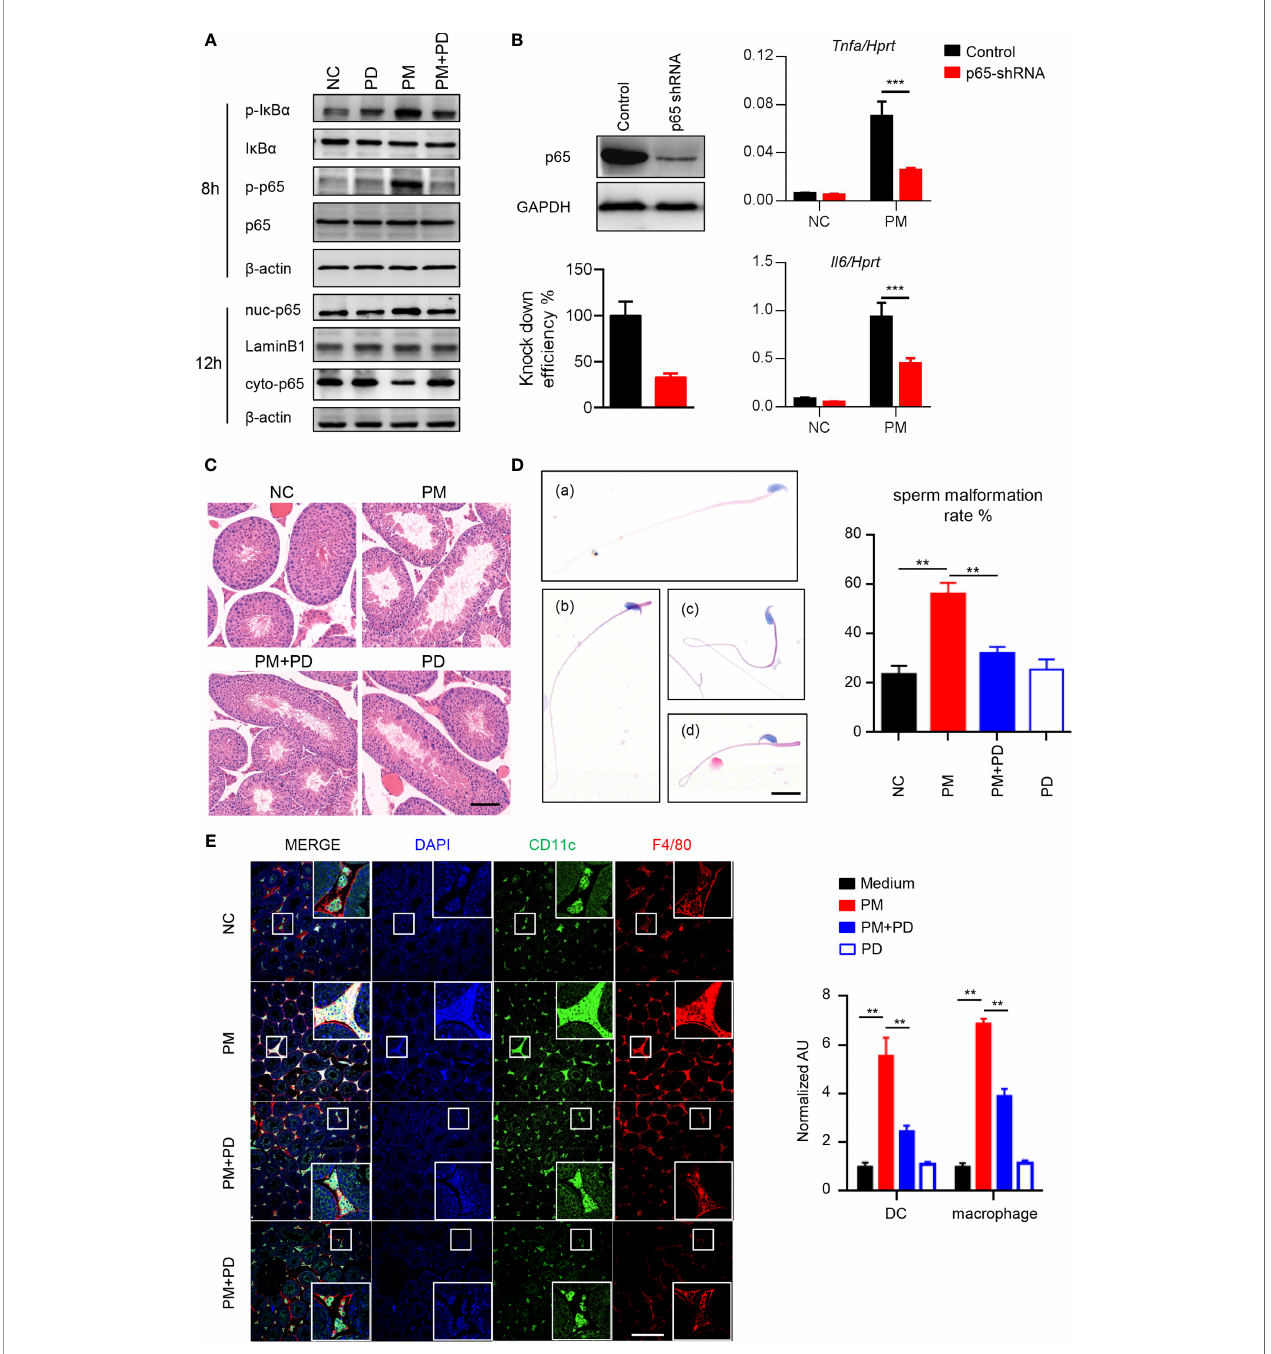
FIGURE 2 | PM exposure induced orchitis in mice is NF- k B signaling dependent. (A) Immunoblot analysis of phosphorylation of I k B a and p65 and protein level of I k B a and p65 in TM3 cells after 200 m g/ml PM administration for 8 hours. b -actin was used as the loading control. (B) Expression analysis of Il6 and Tnfa in the p65 knockdown TM3 cells after 200 m g/ml PM administration for 12 hours. The knockdown ef fi ciency was analyzed by western blot 48 h post transfection (left panel). The intensity of signaling was quanti fi ed. (C) H&E staining evaluation of empty areas of seminiferous tubules in testes of mice after 7 days of PM exposure with or without PDTC administration. In (C – E) , NC, PBS; PM, 400 m g/day PM; PM+PD, 400 m g/day PM + PDTC; PD, PDTC only. Scale bar: 20 m m. (D) H&E staining of typical abnormal sperm morphology: (a) normal sperm; (b) abnormal sperm head; (c) abnormal sperm tail; (d) abnormal sperm head and tail. Scale bars: 10 m m. Sperm malformation rate was quanti fi ed (right). (E) Confocal immuno fl uorescence analysis of dendritic cells and macrophages in cryosections of testes of mice after 7 days of PM exposure with or without PDTC administration. Scale bars: 100 m m. There were 5-6 mice in each group. Data represent three independent experiments in (A) and two independent experiments in (B – E) . Data are presented as mean ± SEM. ** P < 0.01; *** P <